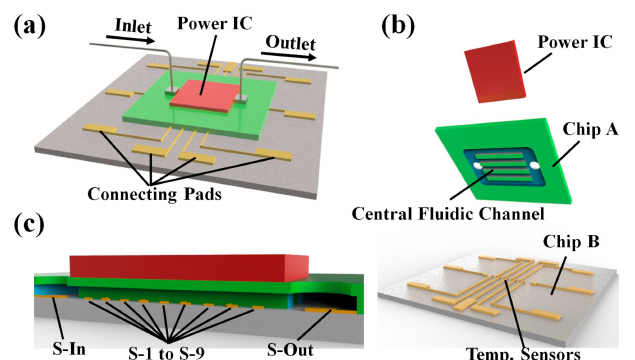
Figure 1. ( a ) The 3-D schematic illustration of the micro-channel based heat sink with integrated thin film temperature sensors and simulated heat source; ( b ) The structure of the heat sink 3D breakdown drawing; ( c ) Sectional view along the inlet to outlet in the direction of heat sink, where the location of thin film temperature sensors (S-In to